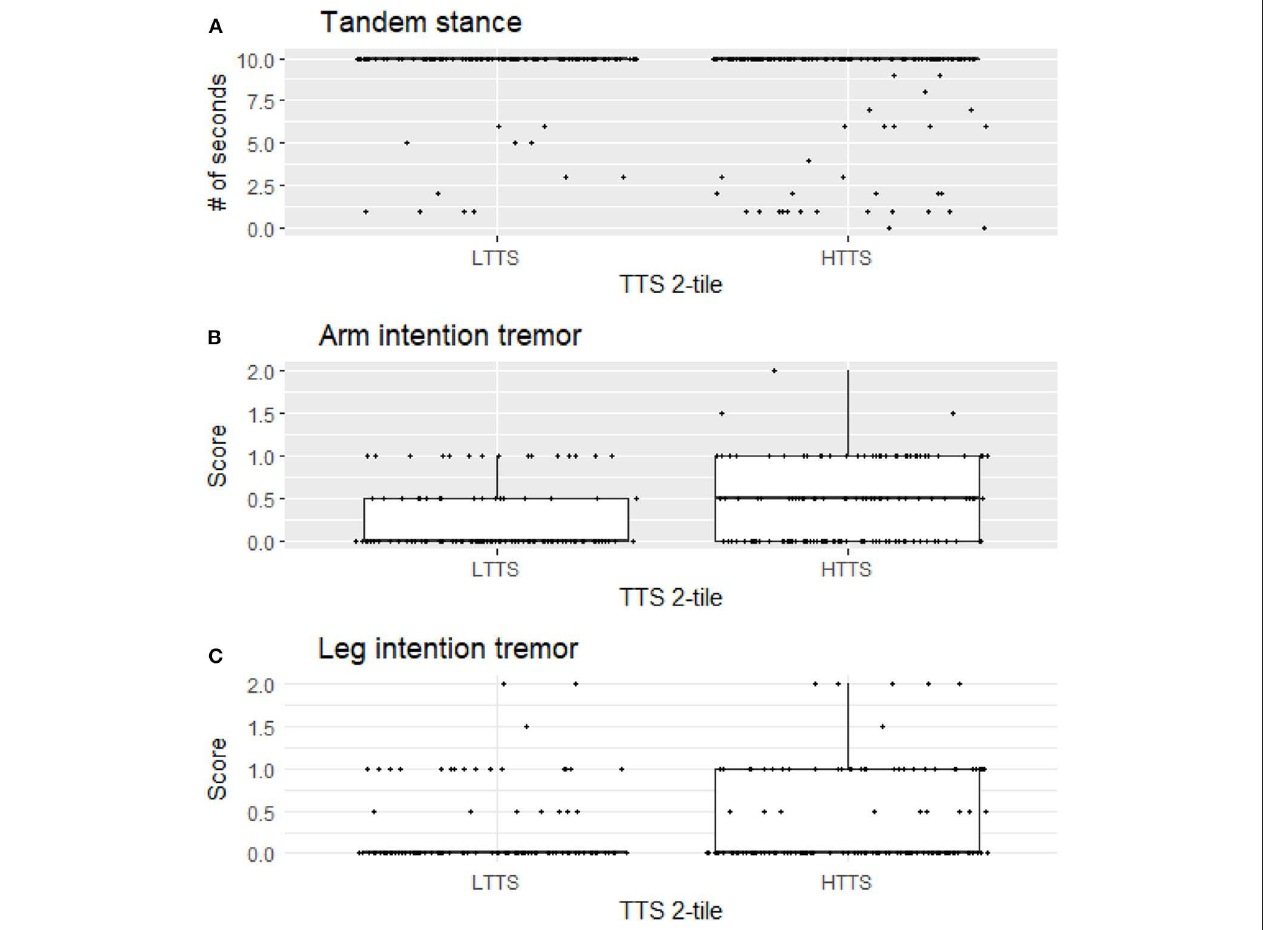
FIGURE 1 | Stationary tandem stance (A) , arm intention tremor score (B) , and leg intention tremor (C) score differ significantly between LTTS and HTTS. LTTS, lower total tremor score; HTTS, higher total tremor score; TTS, total tremor